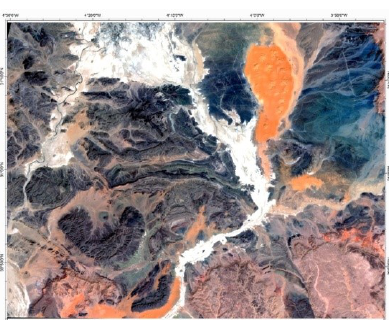
Figure3: RGB (432) true-colour mosaic image of the study area (resulted from pre-processing)